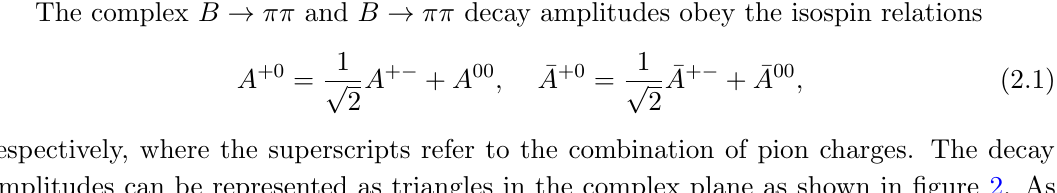
Figure 1 . Leading-order Feynman diagrams shown producing B 0 ! (cid:25) + (cid:25) (cid:0) decays, though the same quark transition can also produce B 0 ! (cid:26) (cid:6) (cid:25) (cid:7) , (cid:26) + (cid:26) (cid:0) and a (cid:6) (cid:12)rst-order (tree) diagram while (b) shows the second-order loop (penguin) diagram. In the penguin diagram, the subscript x in V xb refers to the (cid:13)avour of the intermediate-state quark ( x = u; c; t